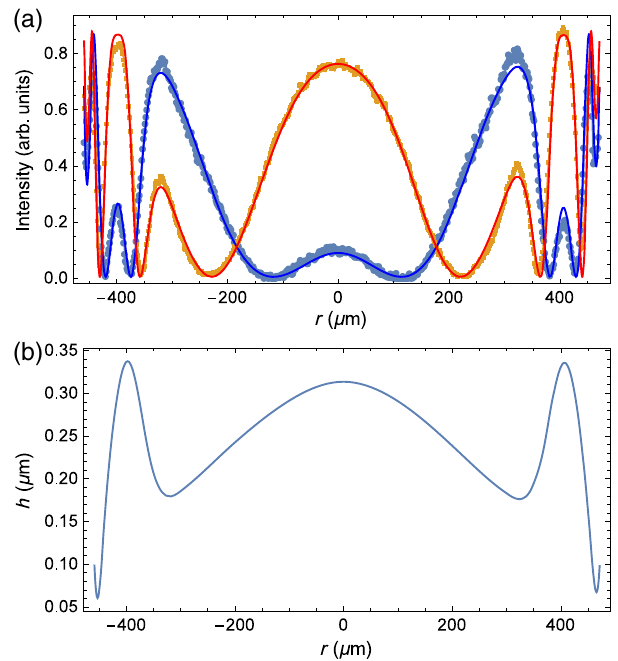
FIG. 7. (a) Measured intensity along a fixed line, i.e., the green line in Fig. 5, for λ ¼ 434 nm (yellow dots) and 546 nm (blue dots), and the corresponding curve fittings (central red and blue curves). (b) Corresponding height profile calculated from (a). FIG. 8. Configuration of confocal